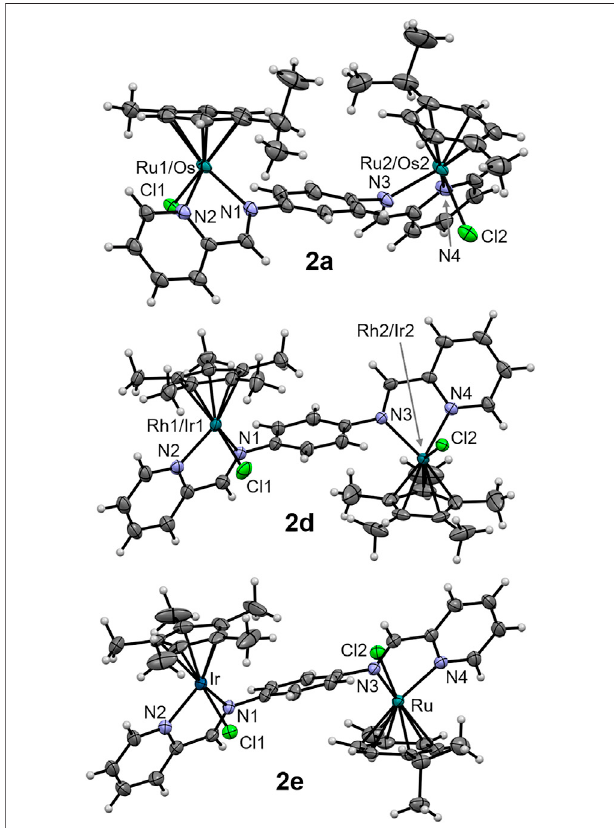
FIGURE 4 | ORTEP representation of one of the two enantiomers of complexes 2a , 2d and 2e drawn at 50% probability level. Any co-crystallized solvent molecules and hexa fl uorophosphate counterions have been omitted for